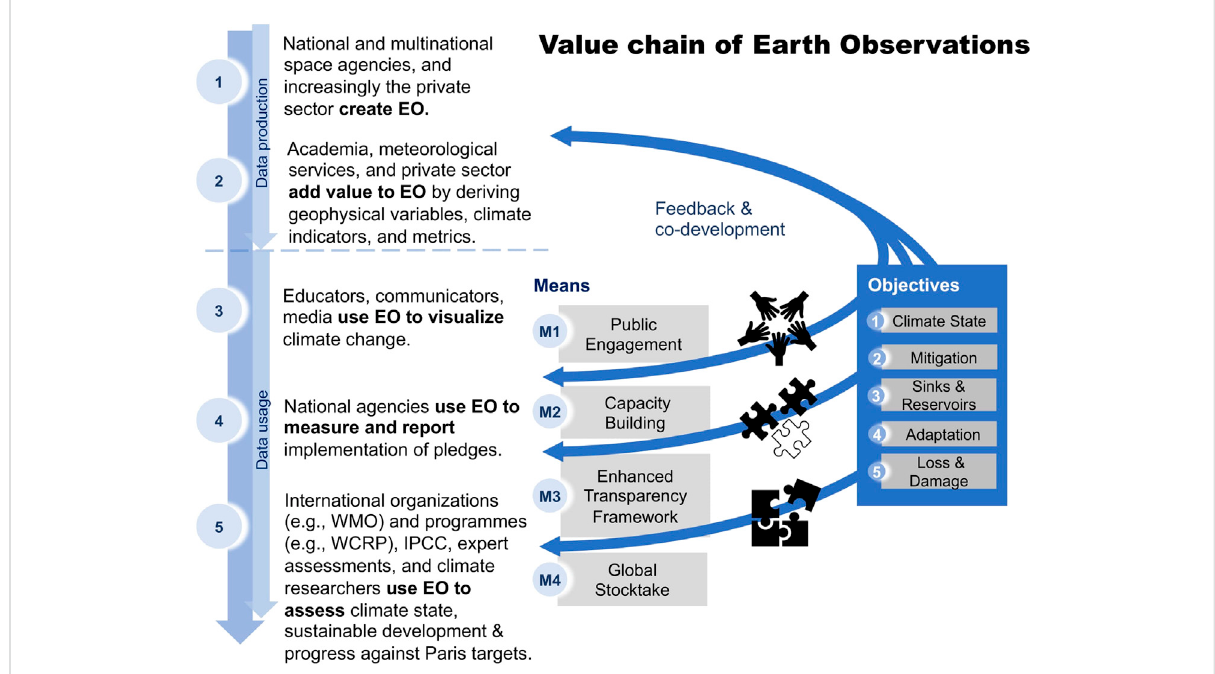
FIGURE 11 To increase the impact and societal bene fi t of EO, a feedback loop that helps co-development of salient EO products useful to policy-makers needs to be introduced in the value chain of EO, which starts with the creation of EO and ends with their